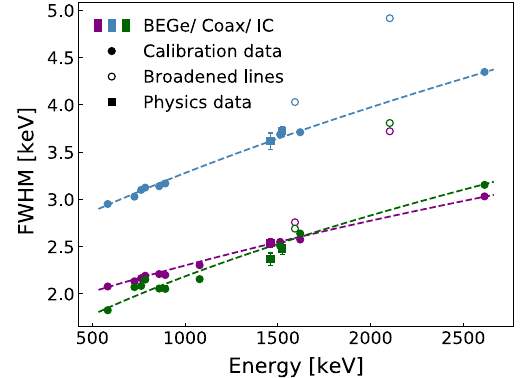
Fig. 6 Effective resolution curves for BEGe (purple), coaxial (blue) and IC (green) DTDs. Open points indicate broadened lines not used to form the resolution curves, namely the double- and single-escape peaks of the 2.6MeV line due to 208 Tl decay. Square markers indicate the exposure-weighted resolutions of the lines in physics data due to 40 K (1460.8keV) and 42 K (1524.7keV) decays Table 1 Parametersofresolutioncurves (Eq. 8)obtainedforeachDTD Detector type